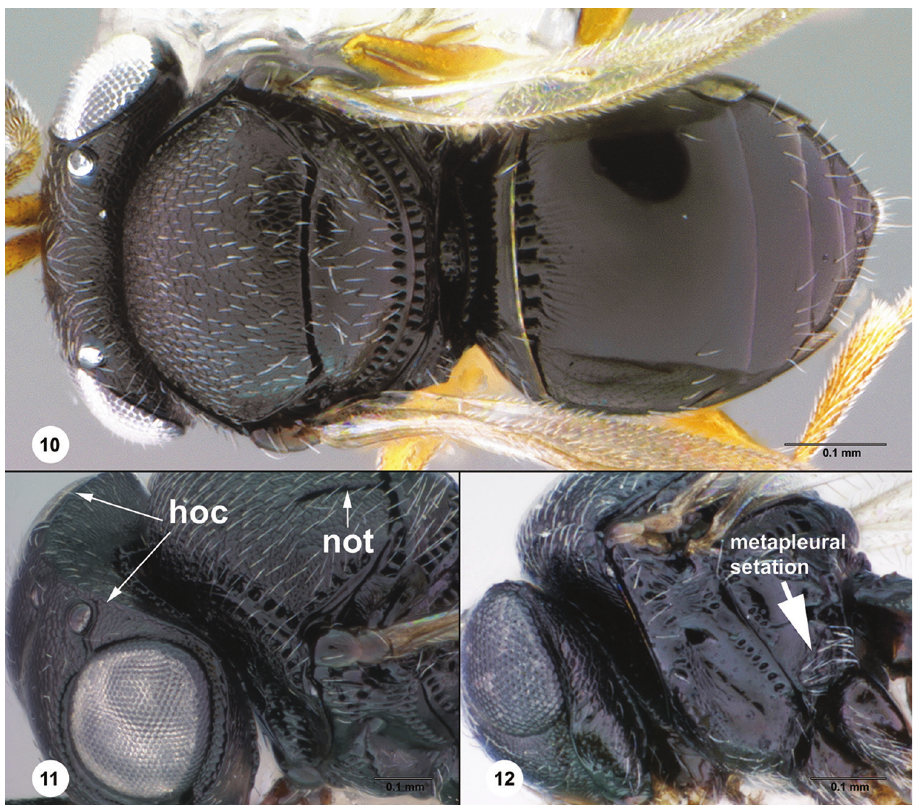
11 Trissolcus euschisti , female (OSUC 334007), head and mesosoma, dorsolateral view 12 Trissolcus thy- antae , (OSUC 76325), head and mesosoma, lateral view. hoc: hyperoccipital carina; not: notaulus; white arrow in Fig. 12 indicates posteroventral setose area of